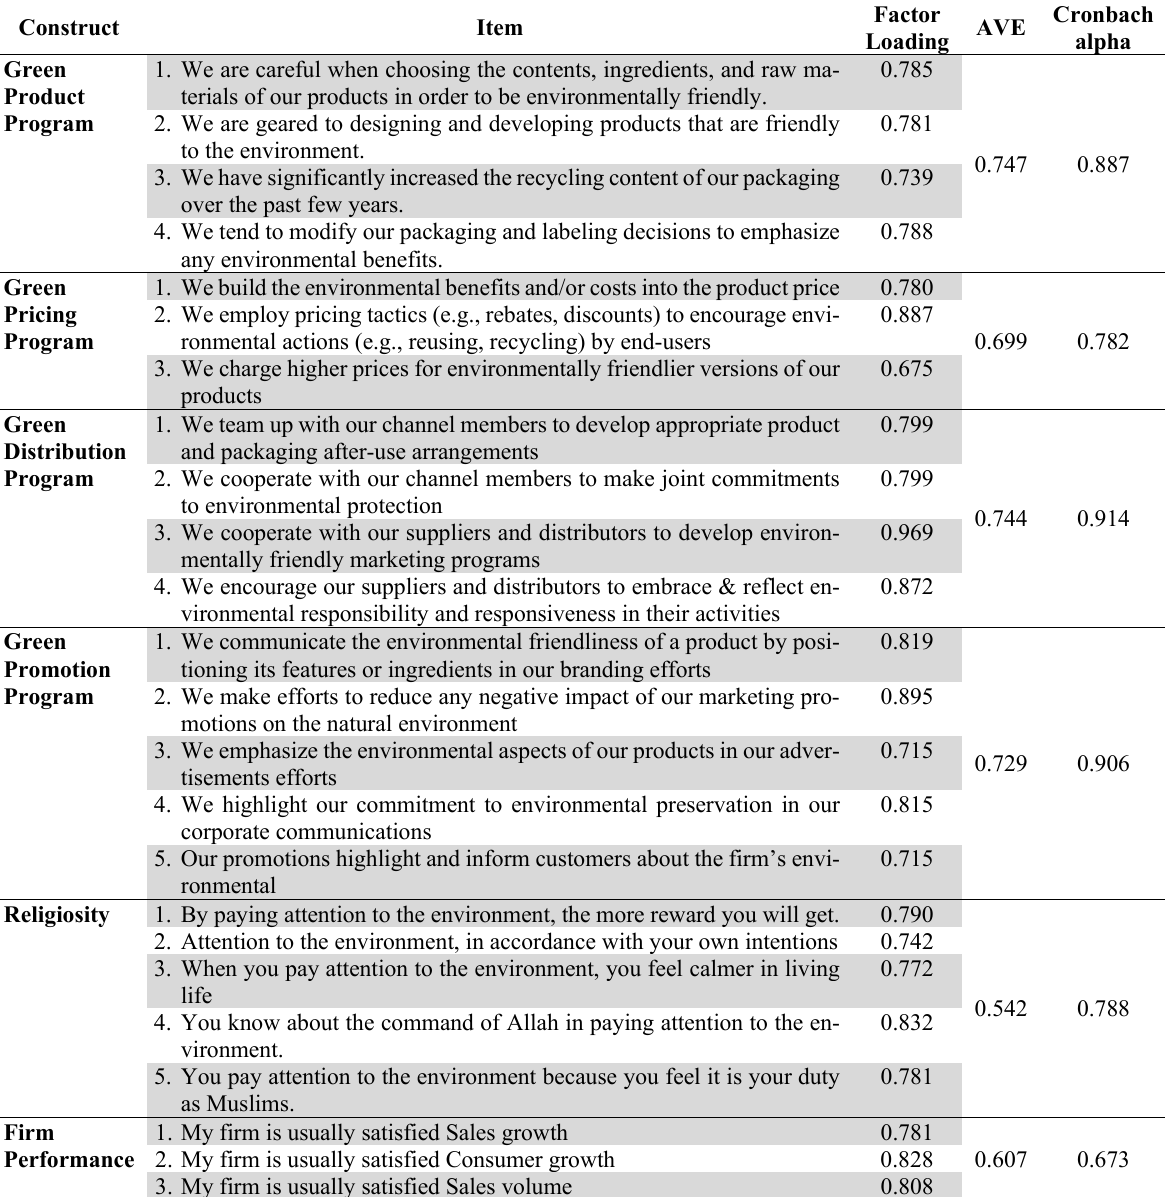
Table 1 Measurement Model Construct